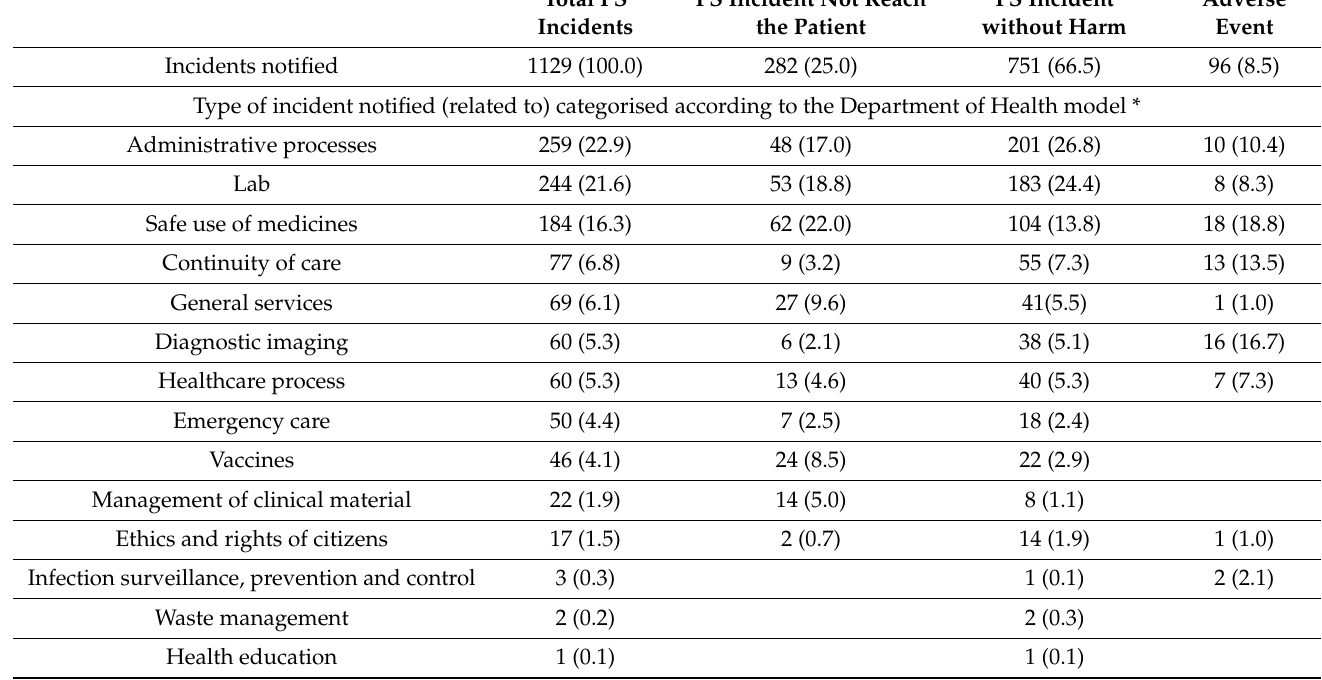
Total PS PS Incident Not Reach PS Incident Adverse Incidents the Patient without Harm